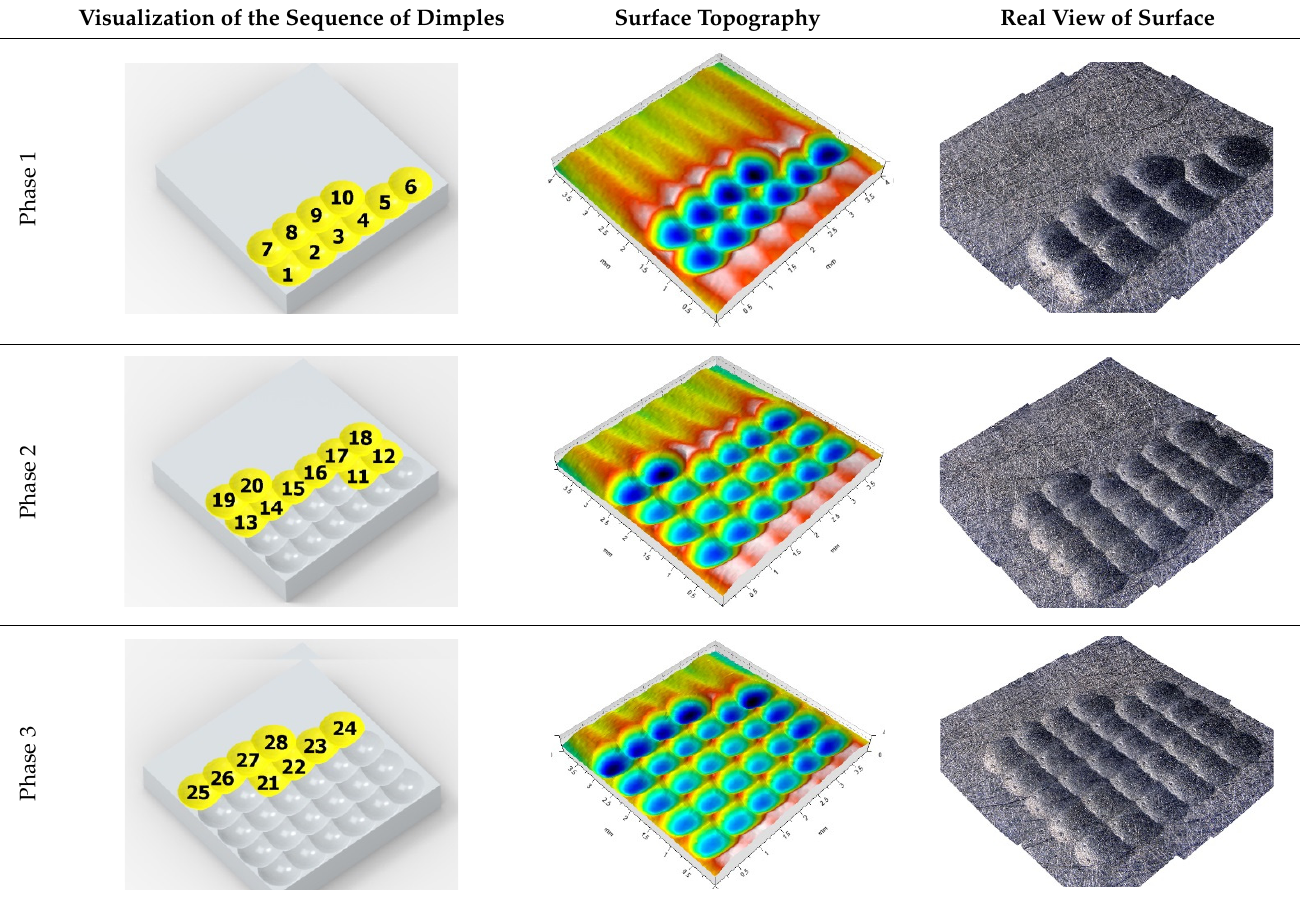
Table 3. Methodology of exerting a sequence of impacts in regular shot peening (RSP). Visualization of the Sequence of Surface Topography Real View of Surface Dimples